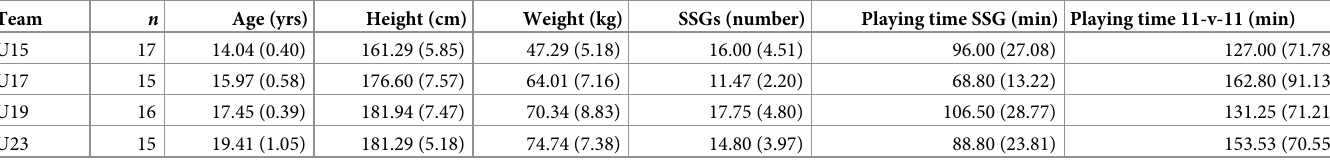
Table 1. Descriptives (mean, SD in brackets) for the elite players ( n = 63) included in the study, classified by age category (i.e.,